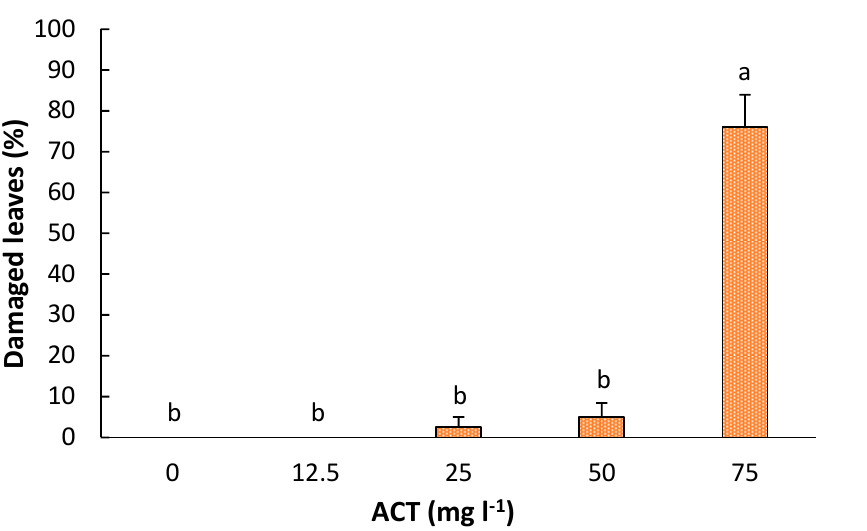
Figure 4. Percentage of damaged leaves exposed to a medium containing different concentrations of Alternaria citri toxin (ACT). Data represent average ± SD values. Bars with different lower-case letters indicate a significant difference by LSD test ( p ≤ 0.05).